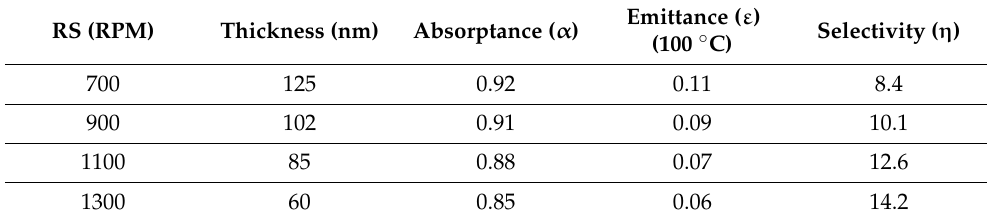
Table 2. Absorptance and emittance values of the green synthesized NiO solar absorber nanocoatings prepared at different